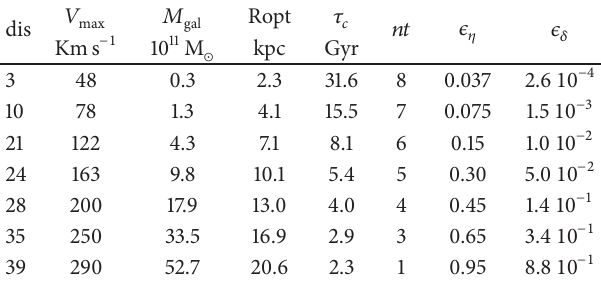
Table 1: Theoretical galaxy models selected to represent a simulated Hubble